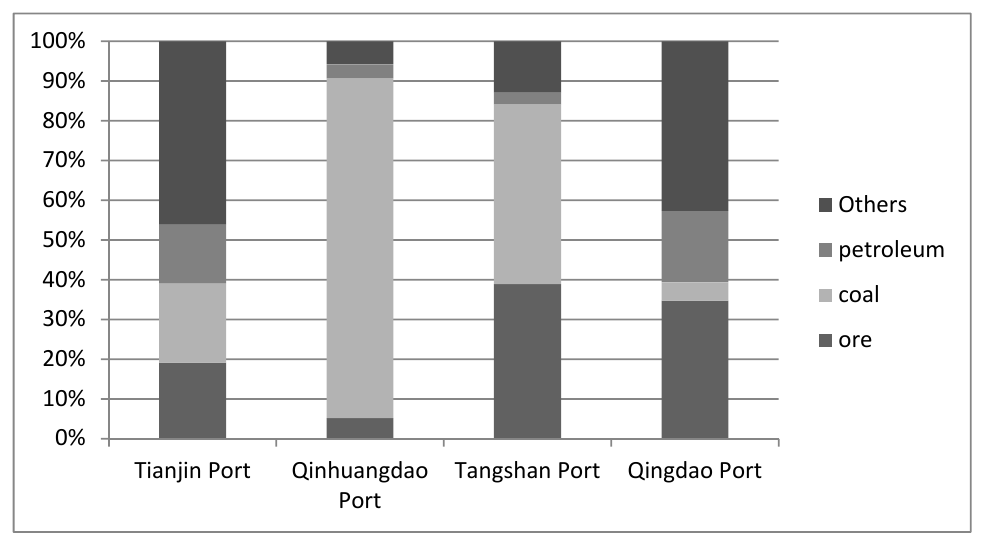
Figure 3. Product Composition ( in ten thousand tons)